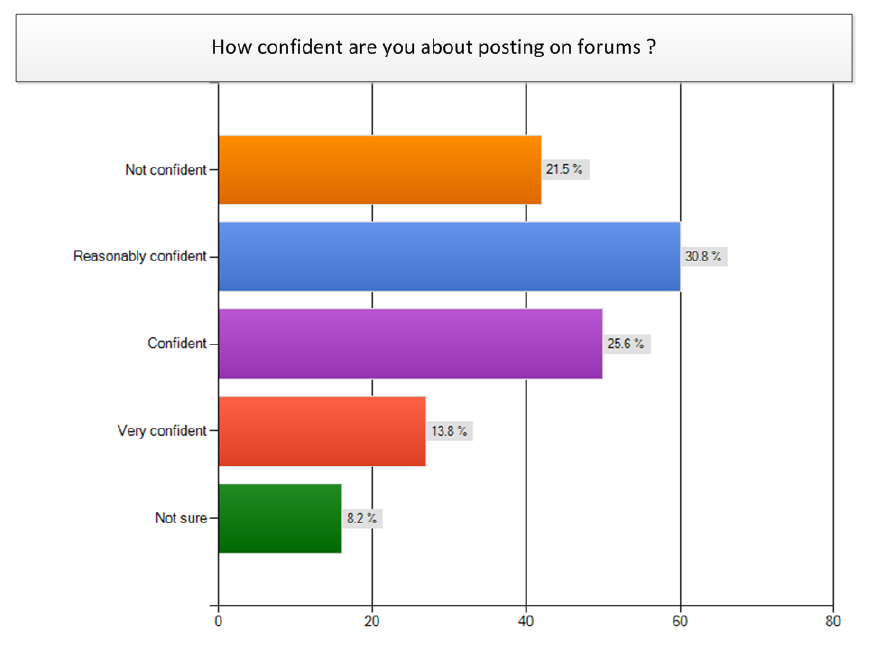
Figure 5 . Confidence levels in forum